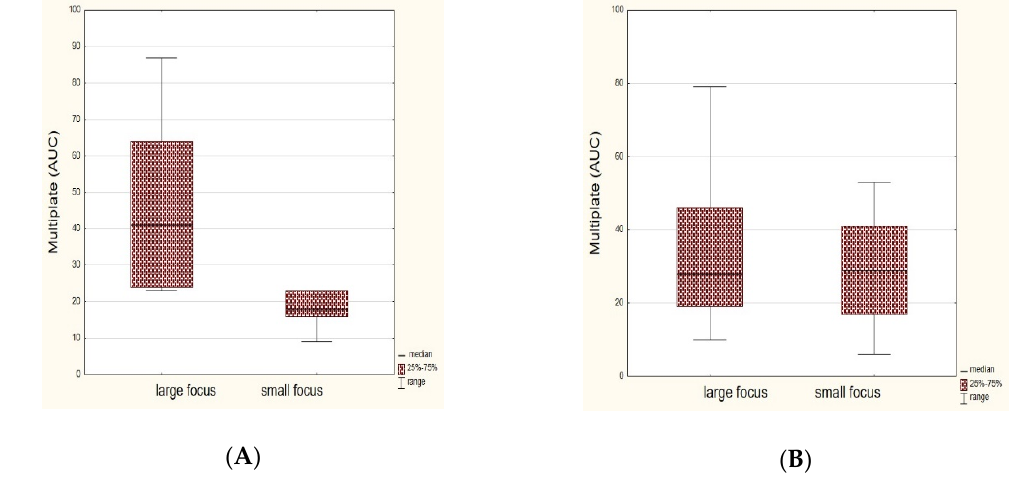
Figure 5. Comparison of the platelet reactivity (in area under the curve (AUC) units) assessed by the Multiplate method in subjects with a large and small ischemic focus in the diffusion ‐ weighted imaging (DWI) sequence, in both the large ‐ artery atherosclerosis subgroup ( A ) and the small ‐ vessel disease subgroup ( B ).